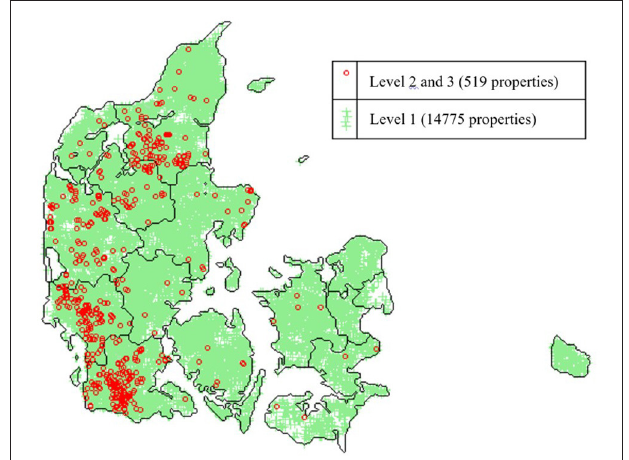
FIGURE 2 | Median within-herd test-prevalence of antibody ELISA test results from June 2009 to February 2021 among herds in the Danish control programme on paratuberculosis.